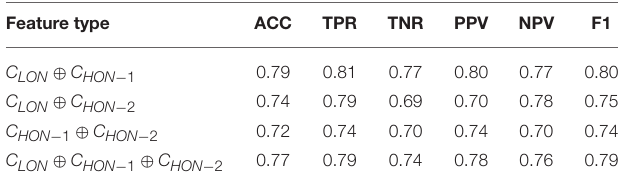
TABLE 5 | Classification accuracy based on simple feature